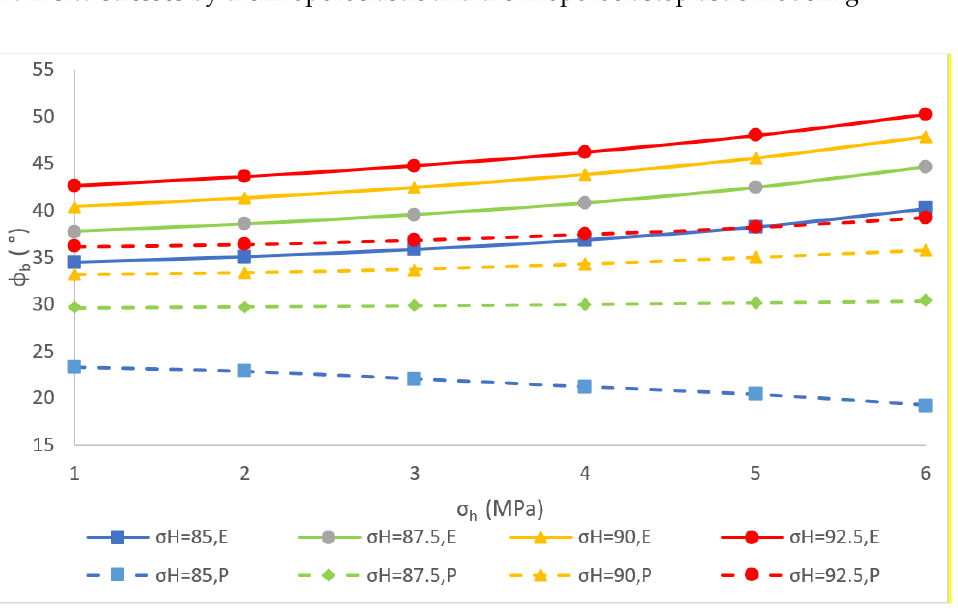
Figure 10. Breakout width and depth for different drilling fluid temperature.